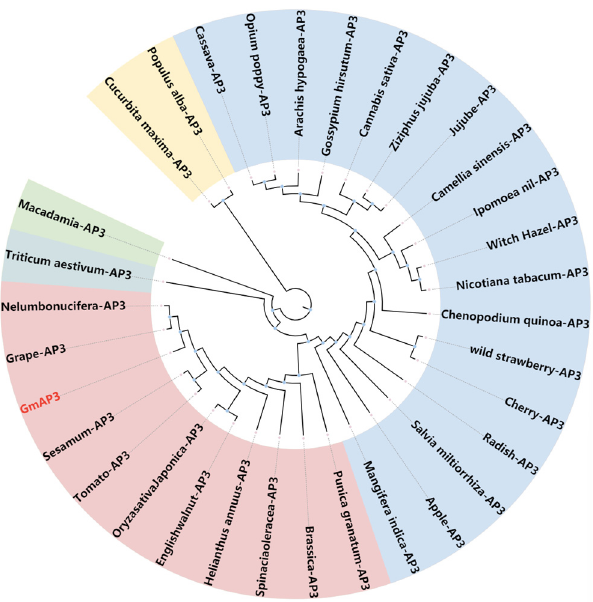
Figure 1. Phylogenetic analysis of AP3 genes from Arabidopsis, grapes, lotuses, rice, tomatoes, cotton, peanuts, apples and cassavas. The phylogenetic tree was obtained through MEGA version 7.0 by Biomatters. Phylogenetic tree decorated by the ITOL website (https://itol.embl.de/; accessed on 15 December 2022). Protein sequences from the NCBI databases were used.